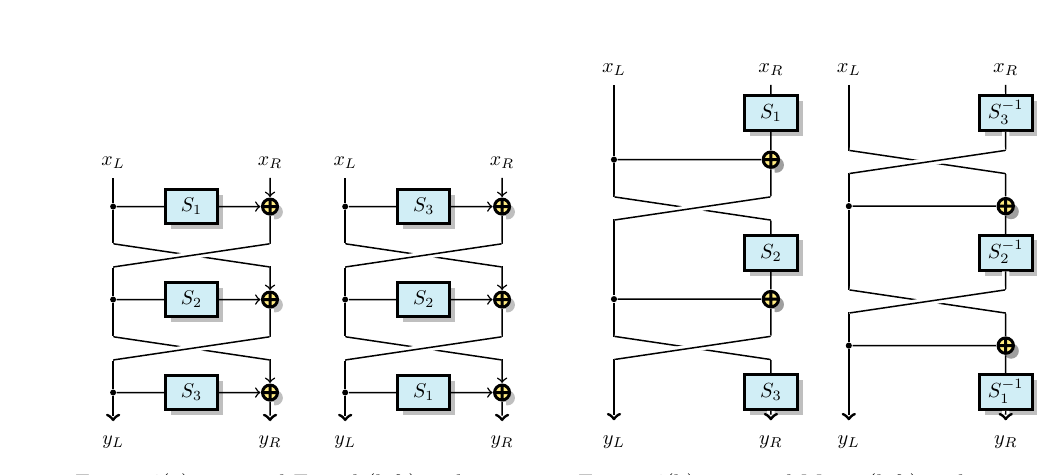
Figure 4(b): 3-round Misty (left) and inverse (right).